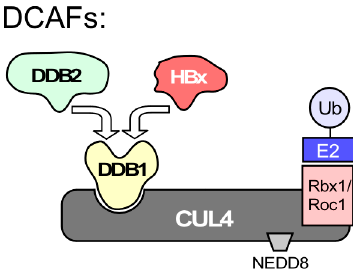
Figure 8. HBx-DDB1 interaction does not necessarily indicate a direct connection to DNA repair. UV-damaged DNA binding protein 1 (DDB1) was reported early on as an HBx interactor. However, different from what the name implies DDB1 does not directly bind to damaged DNA; this function is taken by the distinct DDB2 protein. DDB1’s major function is that of an adaptor in the E3 ubiquitin ligase CRL4, comprising the cullin 4 (CUL4) scaffold protein, a RING finger domain protein (Rbx1 or Roc1) which mediates binding of a ubiquitin conjugating E2 enzyme, and a regulatory site for modification with NEDD8. For ubiquitylation of specific target proteins, DDB1 must interact with DDB1-CUL4 associated factors (DCAFs) which act as substrate receptors. DDB2 is one of multiple cellular DCAFs while HBx is a viral DCAF [31–33]. As HBx binds to the same site on DDB1 as cellular DCAFs do [162] their binding is mutually exclusive.